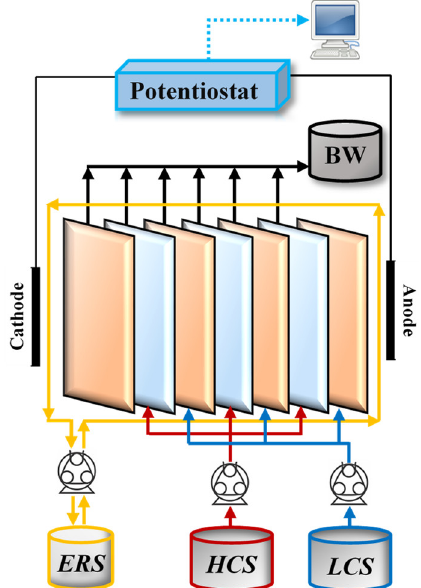
Figure 2. Flow diagram of the RED set-up [14]. Table 2. Operating parameters of the RED tests.